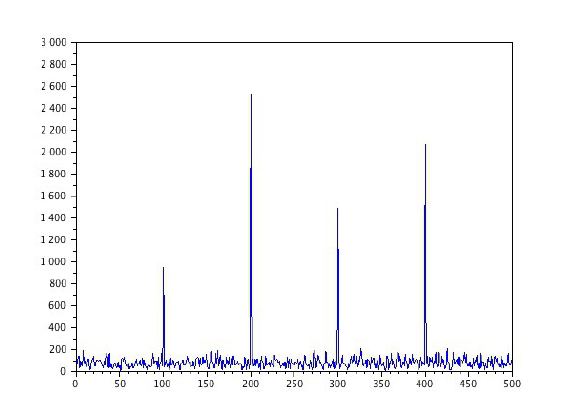
Fig. 2: the same signal as in figure 1 but expressed as a combination of complex exponential vectors. The so-called Discrete Fourier Transform of the signal in figure 1.